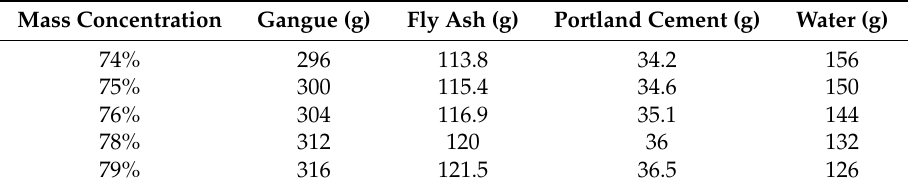
Table 6. Ratios of the slurry composition at different mass concentrations. Mass Concentration Gangue (g) Fly Ash (g) Portland Cement (g)